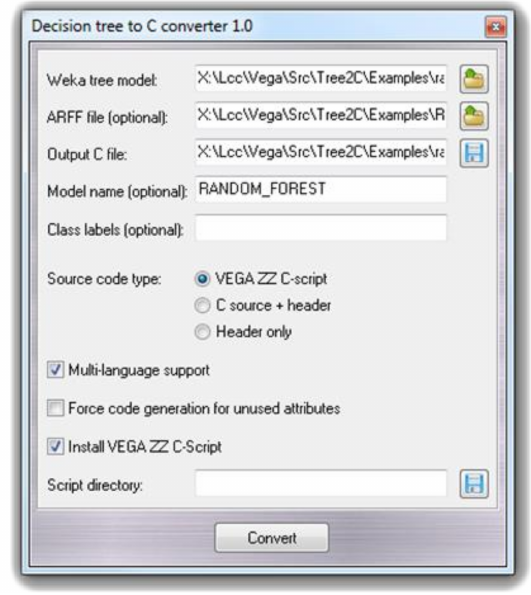
Figure 1. The VEGA ZZ graphical user interface for Tree2C.